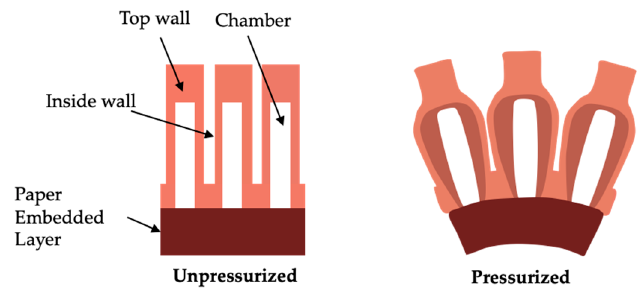
Figure 3. Pneumatic Network [30] by Harvard University.